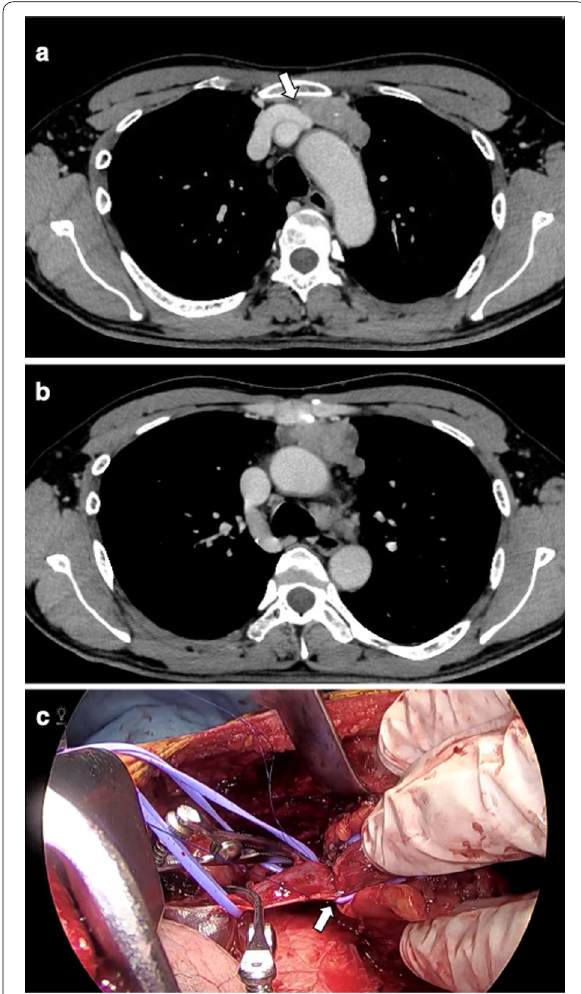
Fig. 1 Preoperative chest computed tomography (CT) findings showed a 60 30 55 mm anterior mediastinal tumor with × × calcification. Contrast-enhanced CT showed mild encasement of left brachiocephalic vein (white arrow) and infiltration of the vein was suspected ( a ). The tumor contained the low-density areas and they might show necrosis or MTCs ( b ). Intraoperative findings showed strong adhesion of the left brachiocephalic vein (white arrow), and therefore partial resection of the vein was performed ( c ) without MG, with infiltration into the pericardium and left brachiocephalic vein, clinically Masaoka stage III.